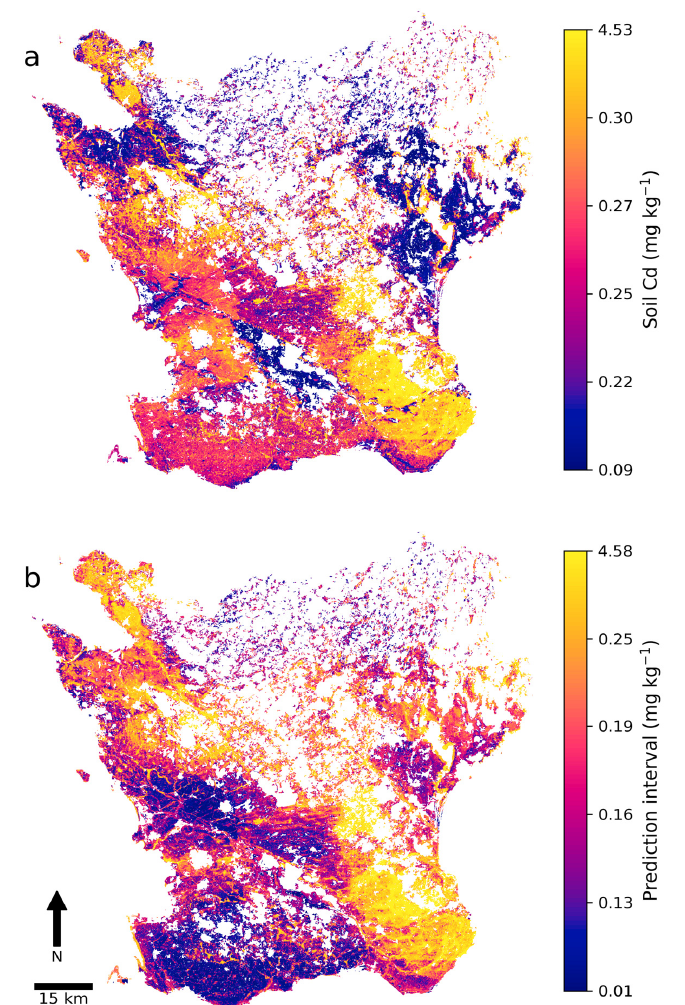
Figure 5. ( a ) Predicted cadmium (Cd) concentrations (mg kg − 1 ) in agricultural topsoil in Skåne and ( b ) the 90% prediction interval width.